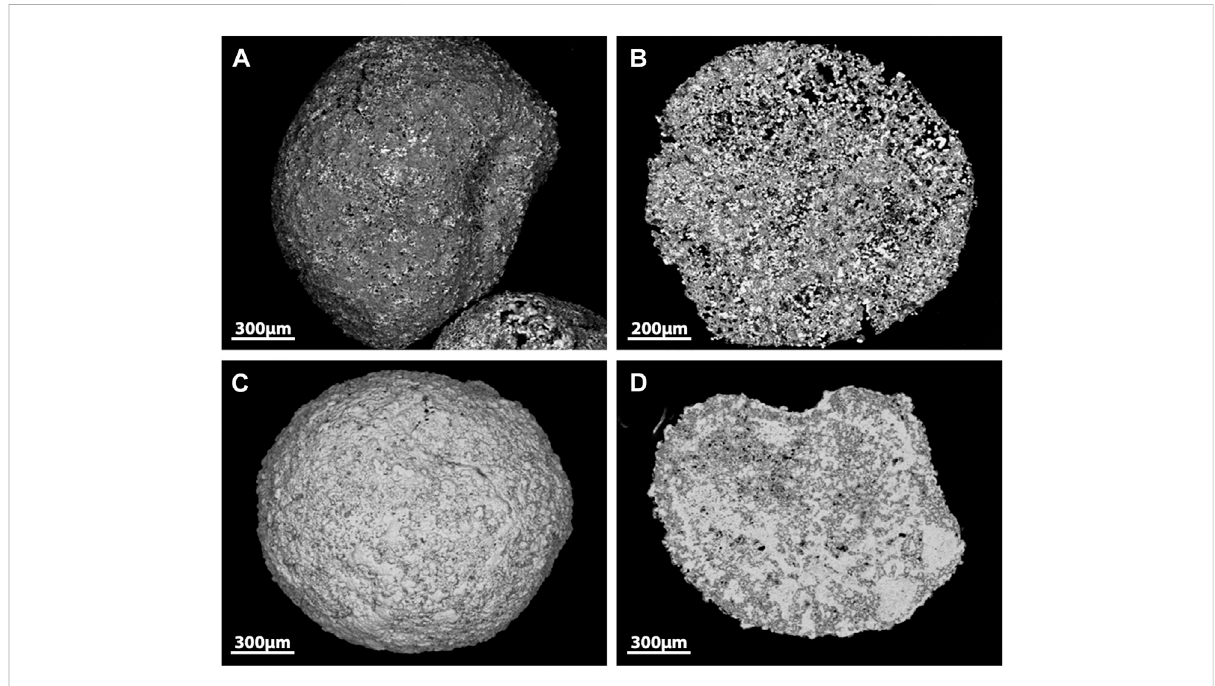
FIGURE 2 SEM images of Ag-phosphate glass sorbent surface (A) , sorbent cross section (B) , Ag-phosphate glass sorbent surface after I 2 capture (C) and after I 2 capture sorbent cross section (D) (Pénélope et al.,